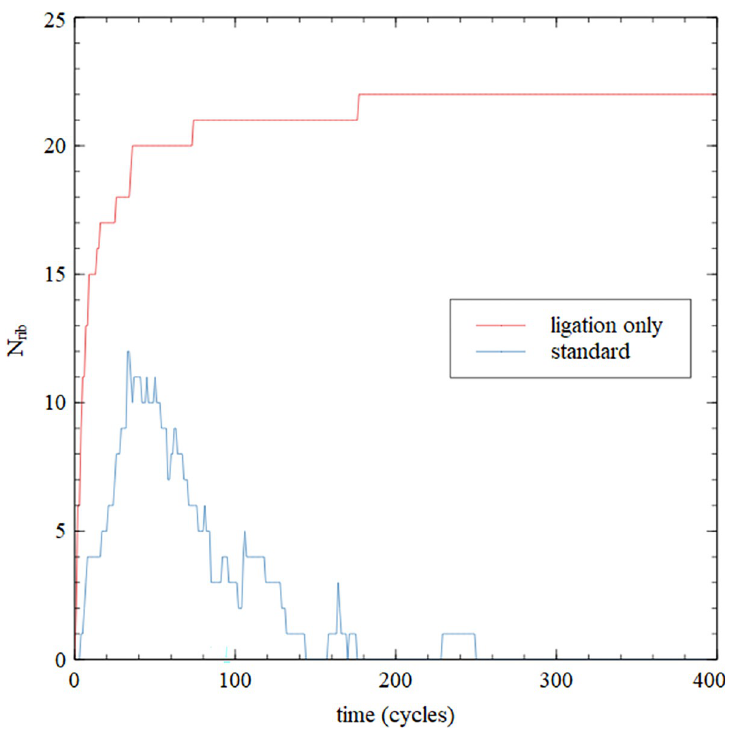
Fig 12. Number of complete ribozymes as a function of time for simulations beginning with the fragments and splits of the F ribozyme catalytic core. The simulation with ligation only shows that multiple copies of the complete ribozyme are assembled from fragments. The simulation with standard parameters allows monomer addition and nucleation, inflow/outflow of monomers and outflow of oligomers, as well as ligation. The full ribozyme is synthesized from the original fragments but disappears after some time because the correct fragments are not